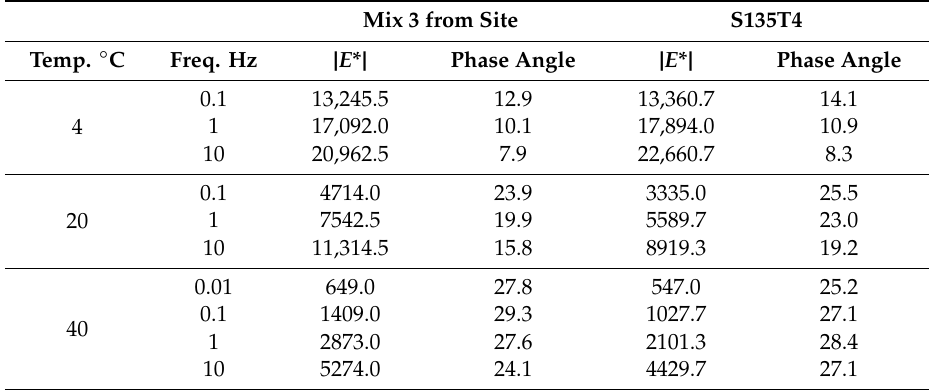
Table 5. Comparison of dynamic modulus results on mixture 3.